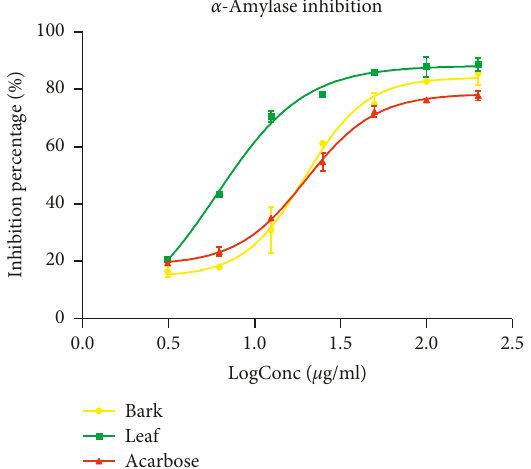
Figure 7: Cholesterol esterase inhibitory activity of the hydro- ethanolic leaf and bark extracts of Psychotria densinervia and orlistat. Values are expressed as mean ± SD ( n � 3).